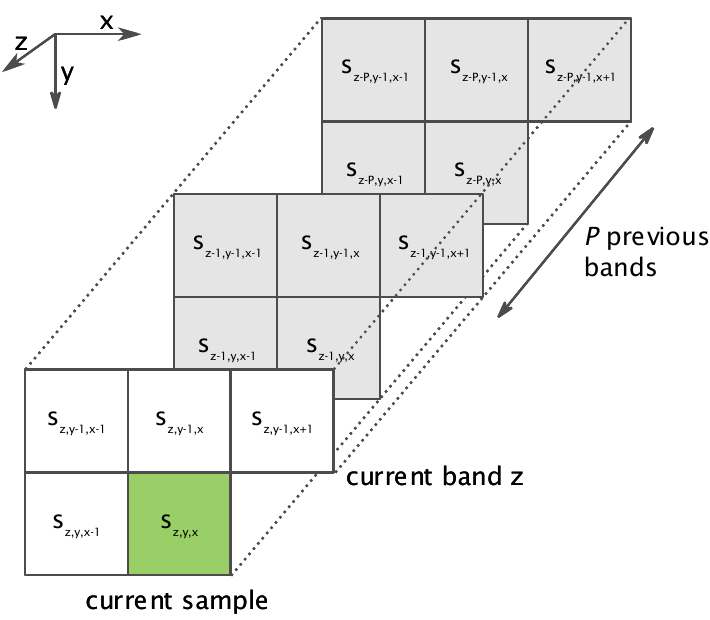
Figure 1. Spatial and spectral vicinity used during the